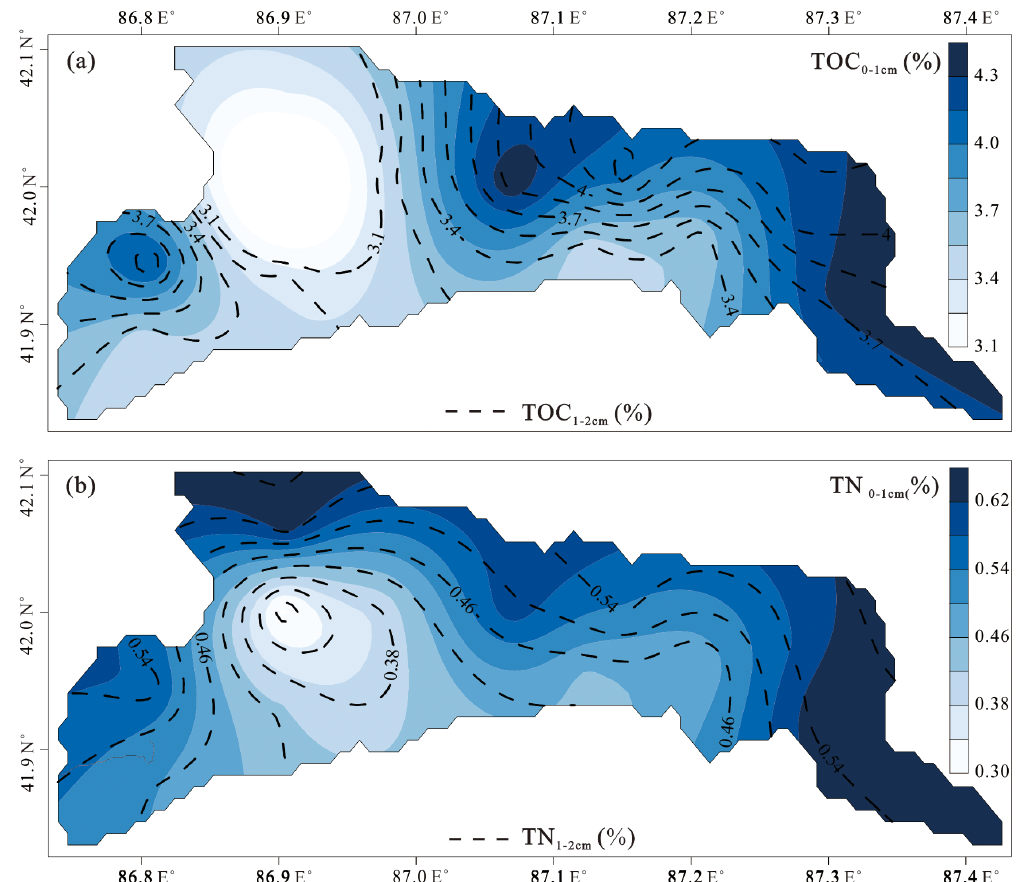
Figure 3. Spatial distributions of (a) total organic carbon (TOC) and (b) total nitrogen (TN) in the 0–1cm (color map) and 1–2cm (dashed